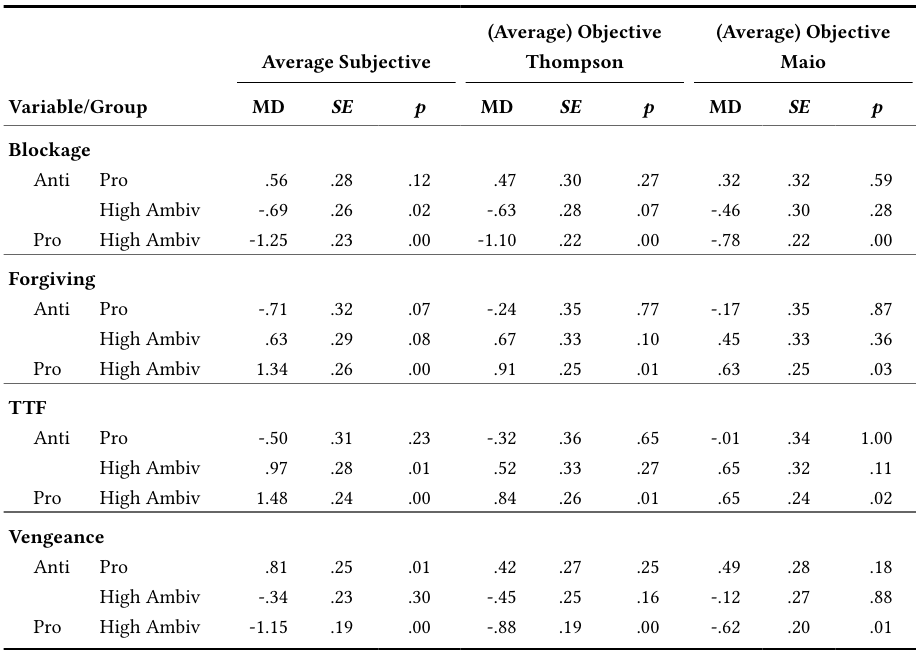
Tukey HSD Comparisons Among High Ambivalence, Anti-, and Pro-Forgiveness